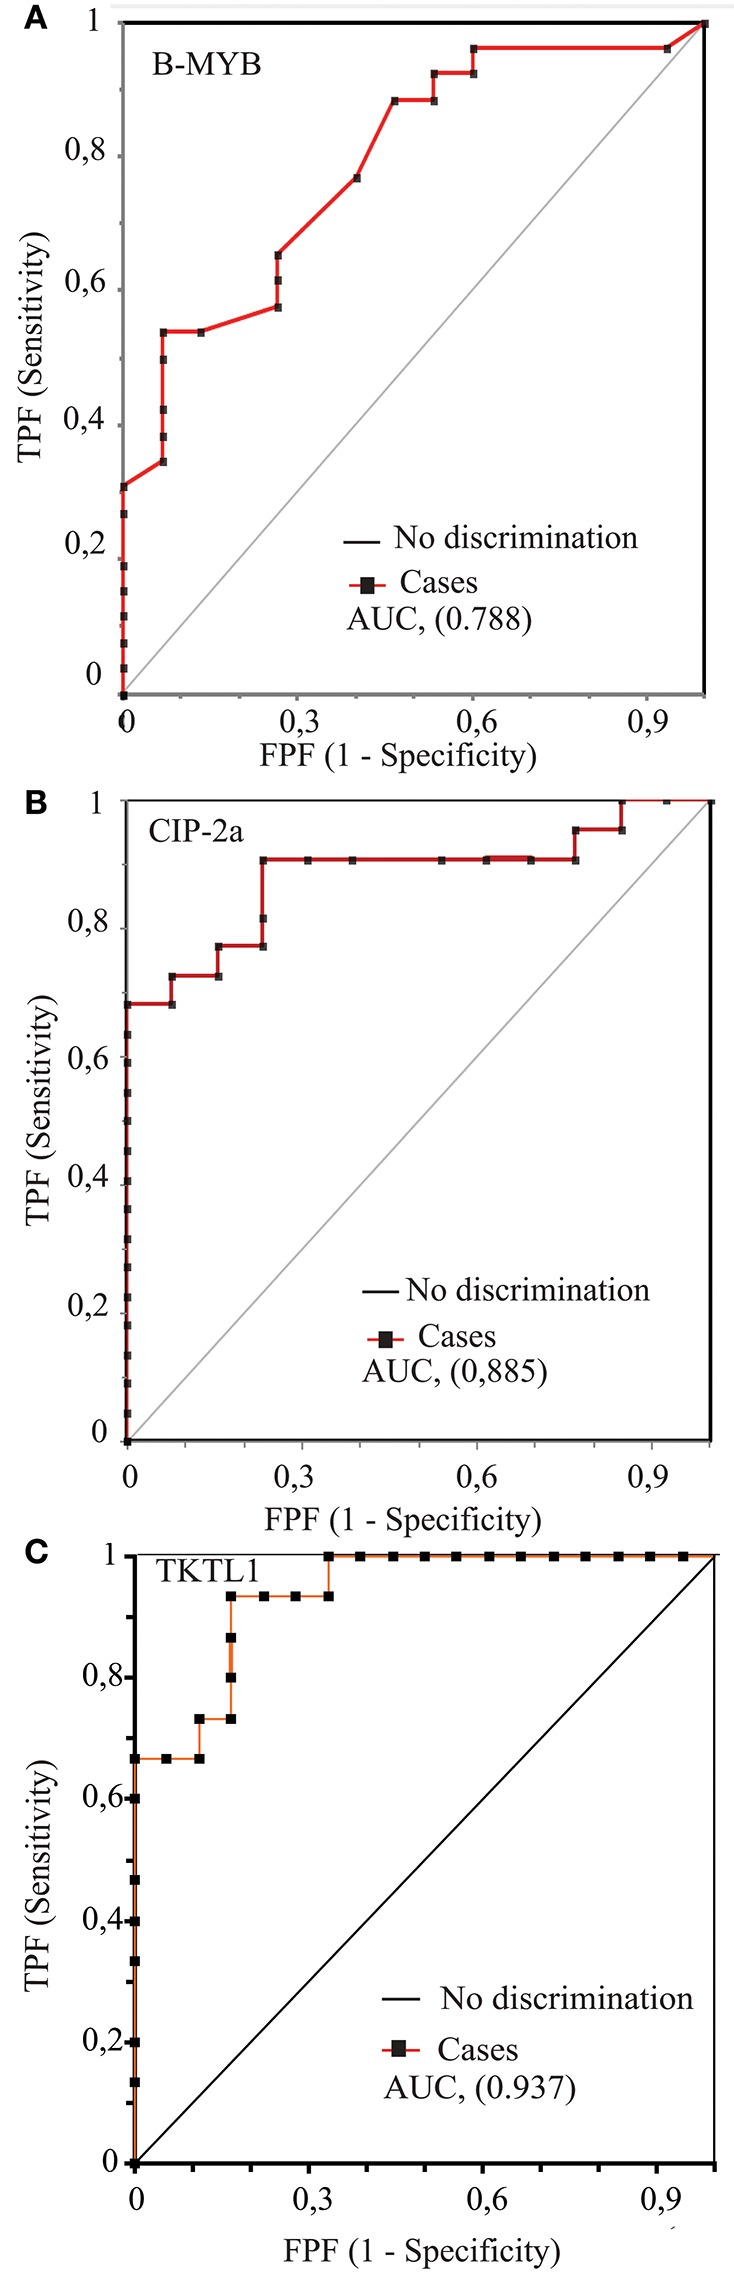
The receiver operating characteristic (ROC) curve analysis of the putative biomarker proteins B-MYB (A), CIP-2a (B), and TKTL1 (C). Details concerning the several diagnostic parameters reckoned from each ROC curve are reported in Table 3 (q. v.). In all three panels the value of the area under the curve (AUC) is shown between brackets as well as the no discrimination (chance) line joining the bottom left angle with the top right angle, the area of which is 0.5. In all the three instances the AUC values significantly differ (P < 0.0001) from the no discrimination (chance) area value (see also Table 3). TPF, true positive fraction or Sensitivity. FPF, false positive fraction (1-Specificity).